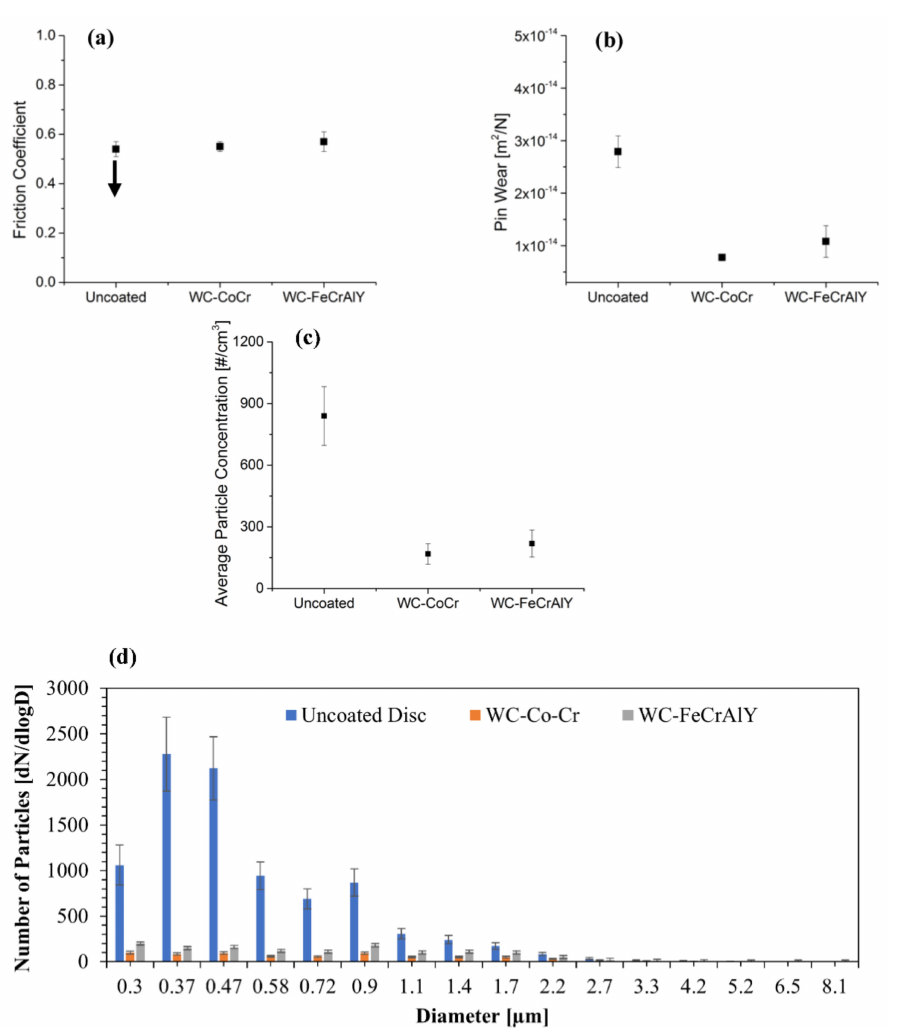
Figure 7. Comparison of ( a ) CoF, the downward pointing arrow for the WC-CoCr coating represents the absence of the achievement of steady state in CoF and the continuous decrease in the CoF magnitude until the end of the testing duration; ( b ) Pin wear; ( c ) Average particle concentration with all pairings; and ( d ) The particle number distribution with respect to the different OPS channel diameters for all three